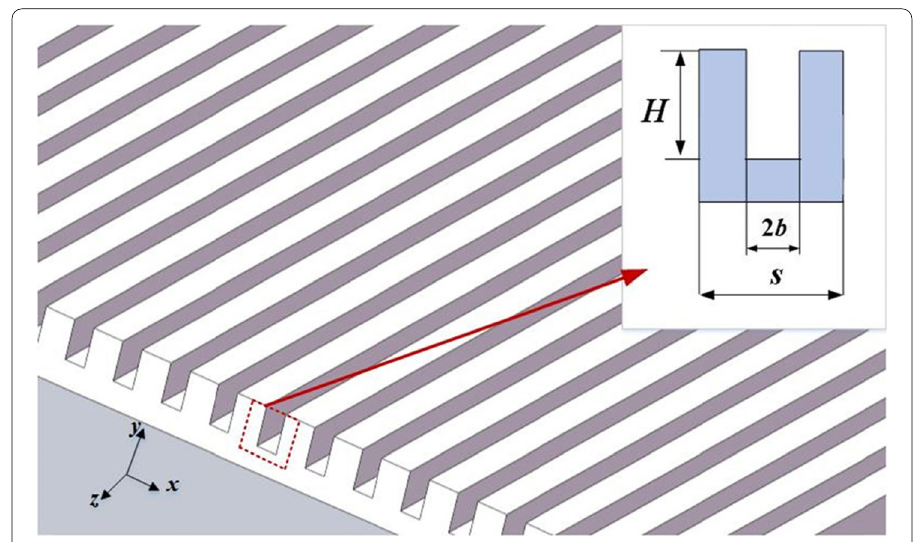
Fig. 1 Schematic illustration of the acoustic metasurface with subwavelength